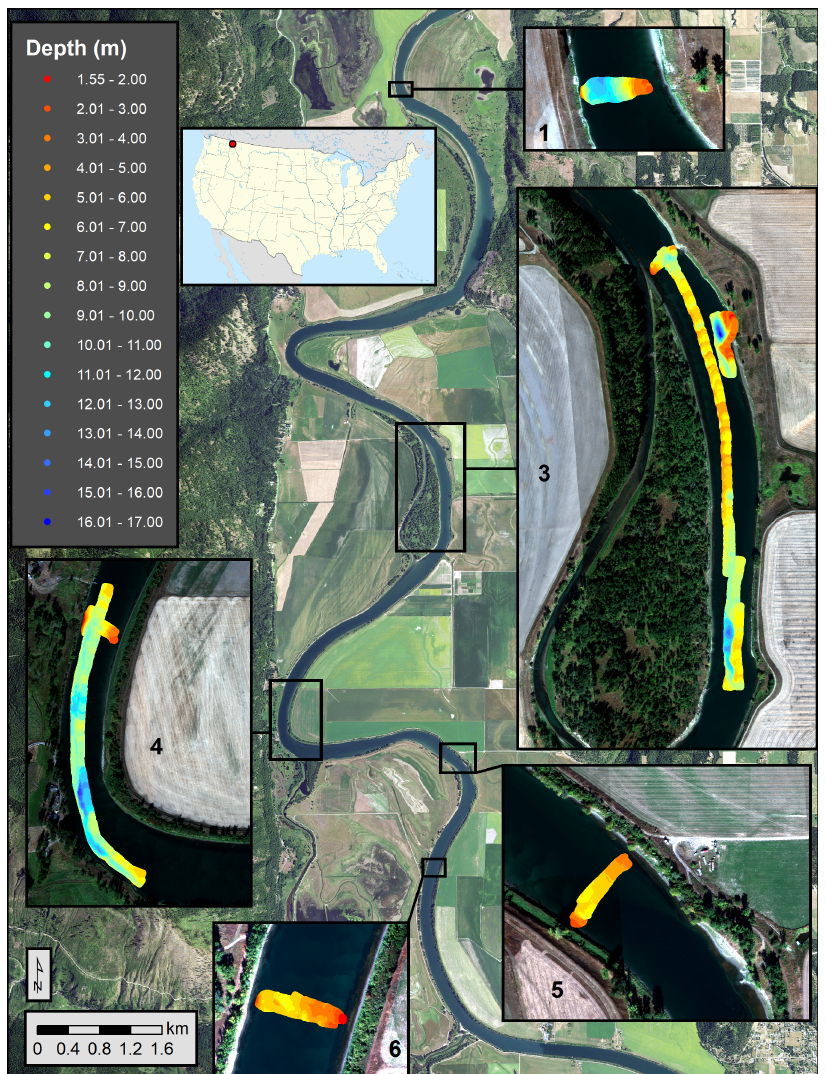
Figure 1. Study area along the Kootenai River in northern Idaho, USA. The index map shows the location of the study area in the context of the United States as a red dot. The scale bar pertains to the overview map in the background. Zoom insets are provided for each of five study sites, with sites 1, 5, and 6 drawn at the same scale of 1:6000, whereas sites 3 and 4 are more extensive and are depicted at a scale of 1:12,000. Depth measurements derived from a multibeam echosounder survey are shown for each site and the same legend applies to all of the insets. The channel is typically on the order of 150 m wide, with flow from south to